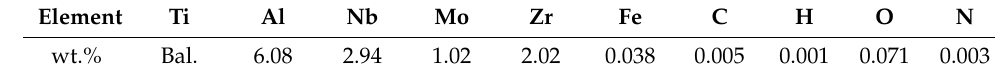
Table 1. The main chemical composition of TA31 [27].